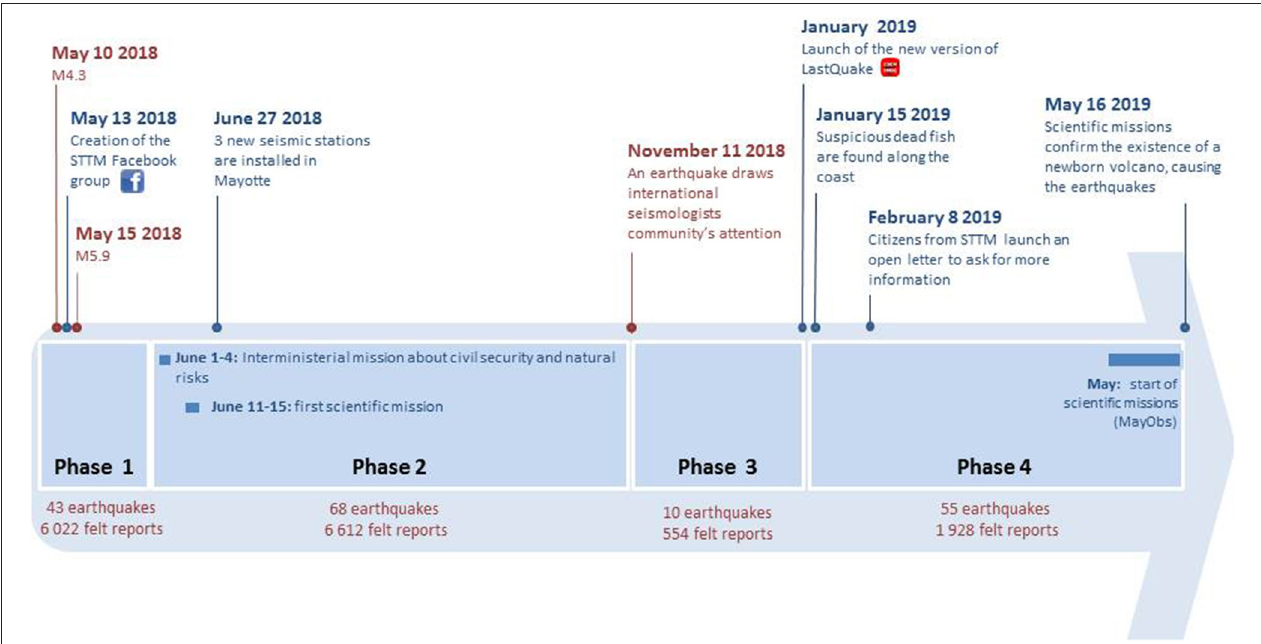
FIGURE 1 | Seismo-sociological phases of Mayotte case study. Number of earthquakes corresponds to M > 4 events displayed on LastQuake. Many more earthquakes were felt by the population but due to lack of sensors, no data was available. For phase 4, 20 additional earthquakes were displayed with no magnitude or location, thanks to the new version of the app. Felt reports correspond to testimonies left by eyewitnesses on EMSC’s services, including